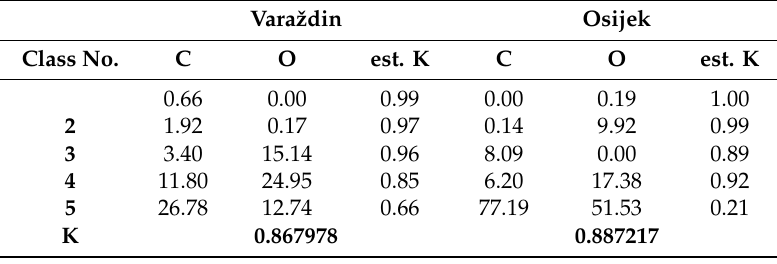
Table 1. The accuracy assessment of Support Vector Machine for Varaždin (left) and Osijek (right) (modified from